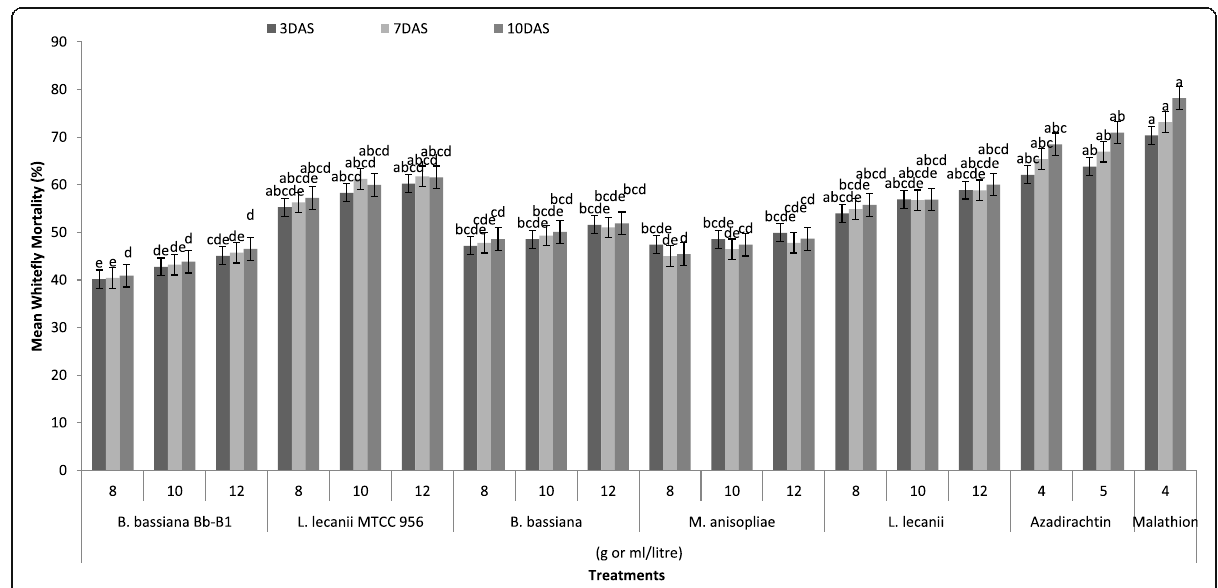
Fig. 2 Mean mortality (%) ± SE of B. tabaci recorded at different time intervals ( DAS days after spray). Treatment columns bearing different alphabets are significantly different from other treatments according to Duncan test ( P =